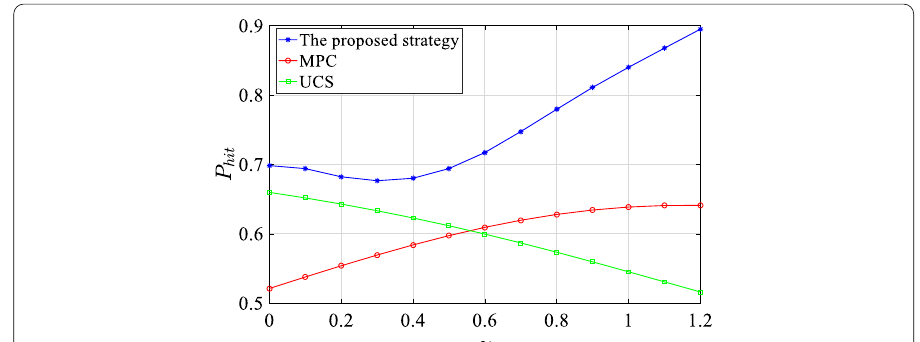
Fig. 10 The comparison of P hit between PBCS, UCS and the proposed